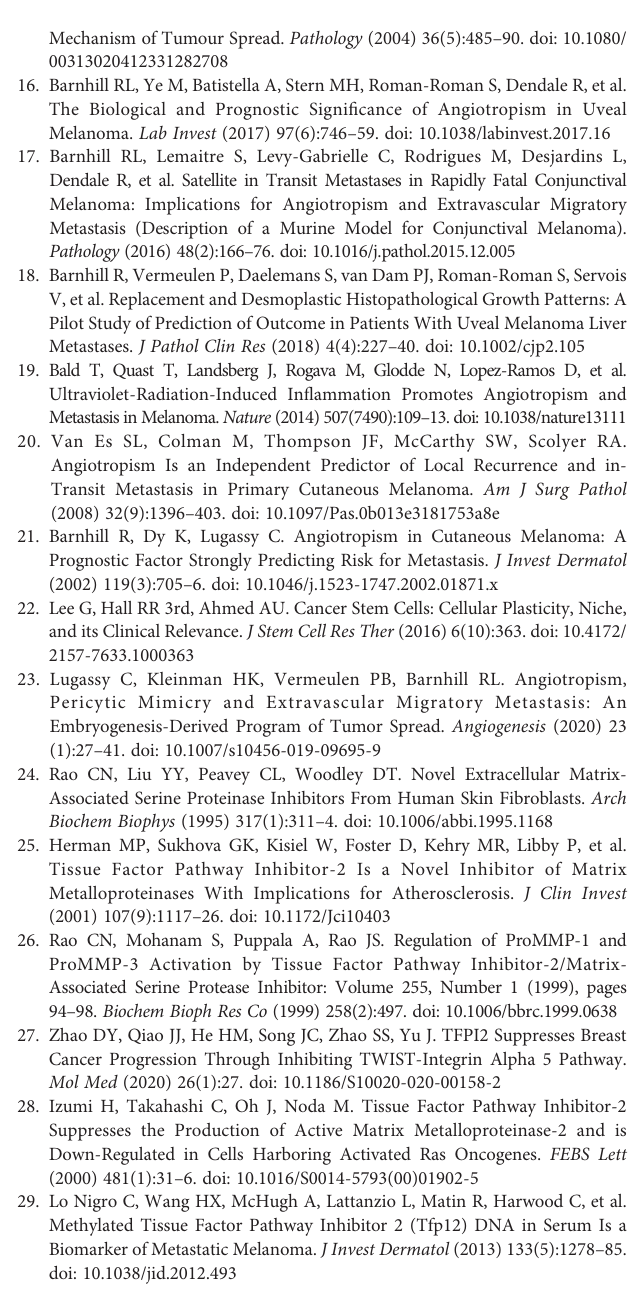
and TCGA-CM, which were further investigated by KEGG pathway enrichment analysis (D) . Supplementary Figure 8 | Prognostic signi fi cance of angiotropism in melanoma Kaplan – Meier estimates showed that there were no signi fi cant differences in 5-year or overall survival time between angiotropism-present and angiotropism-absent patients in TMU-CM cohort. Supplementary Figure 9 | Negative correlation between expression of TFPI2 and BAP1 Stronger correlation of TFPI2 with BAP1 mRNA expression levels from TCGA-UM data than